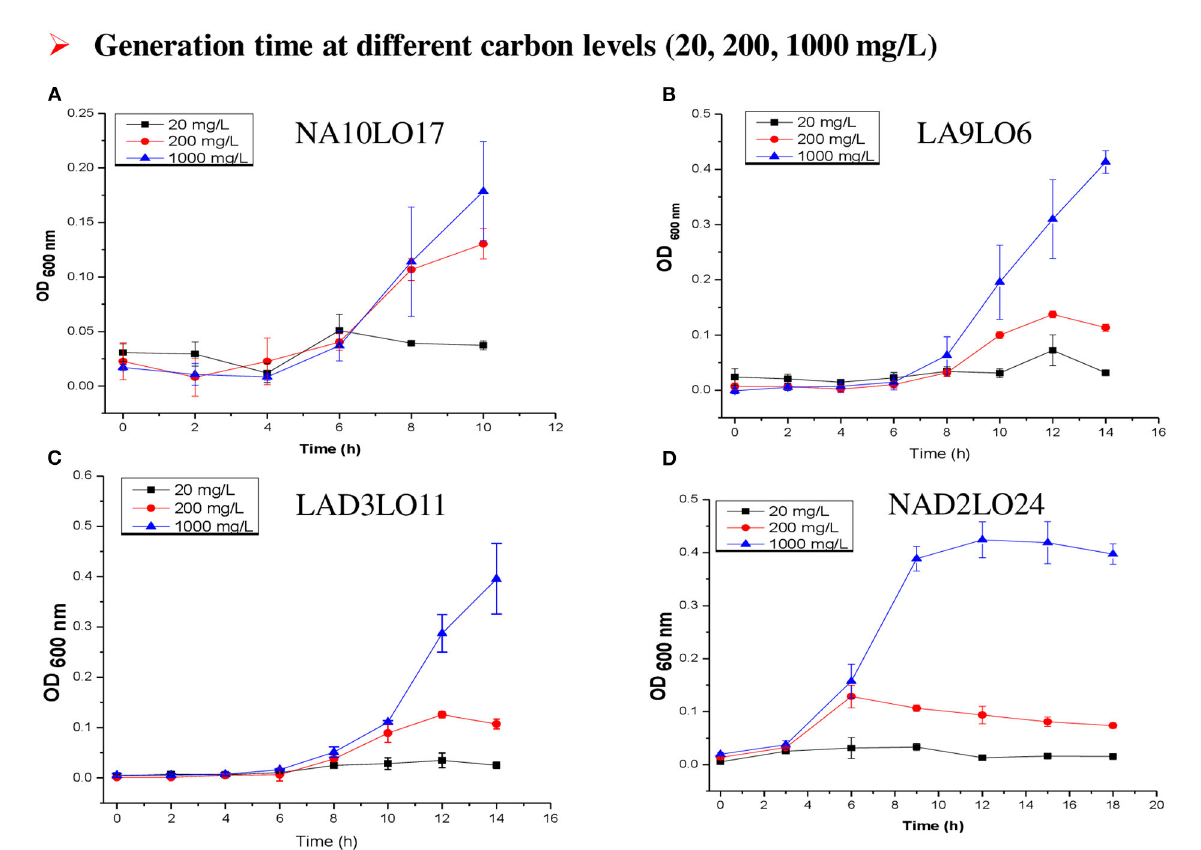
FIGURE2 (A–D) Growth of (A) NA10LO17, (B) LA9LO6, (C) LAD3LO11, and (D) NAD2LO24 in different carbon concentrations (20, 200, and 1,000mg L − 1